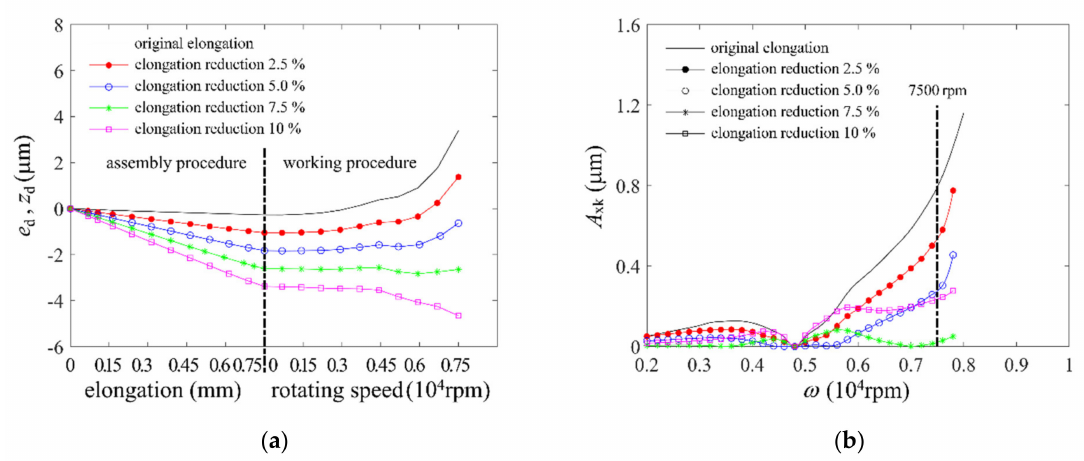
Figure 14. Static and dynamic properties for flawed rod–disk rotor. ( a ) Disk–centre shift; ( b )